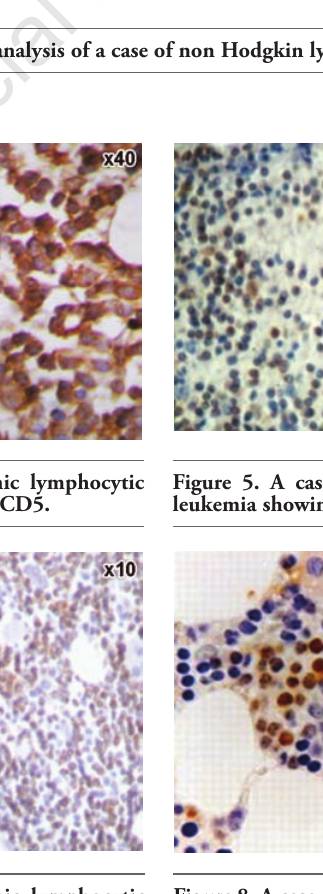
Figure 7. A case of chronic lymphocytic leukemia showing positive Bcl2.